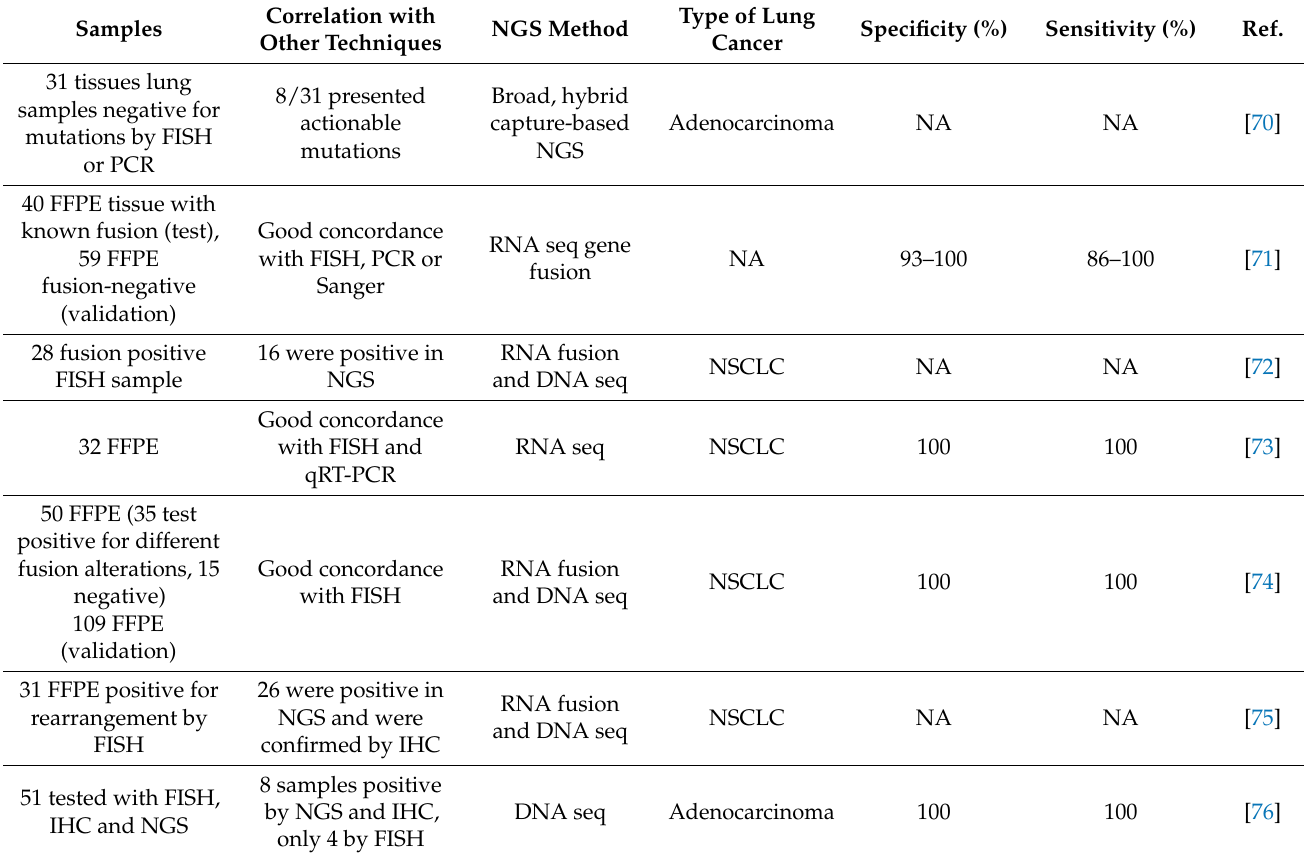
Table 3. Studies describing the implication of NGS in lung cancer